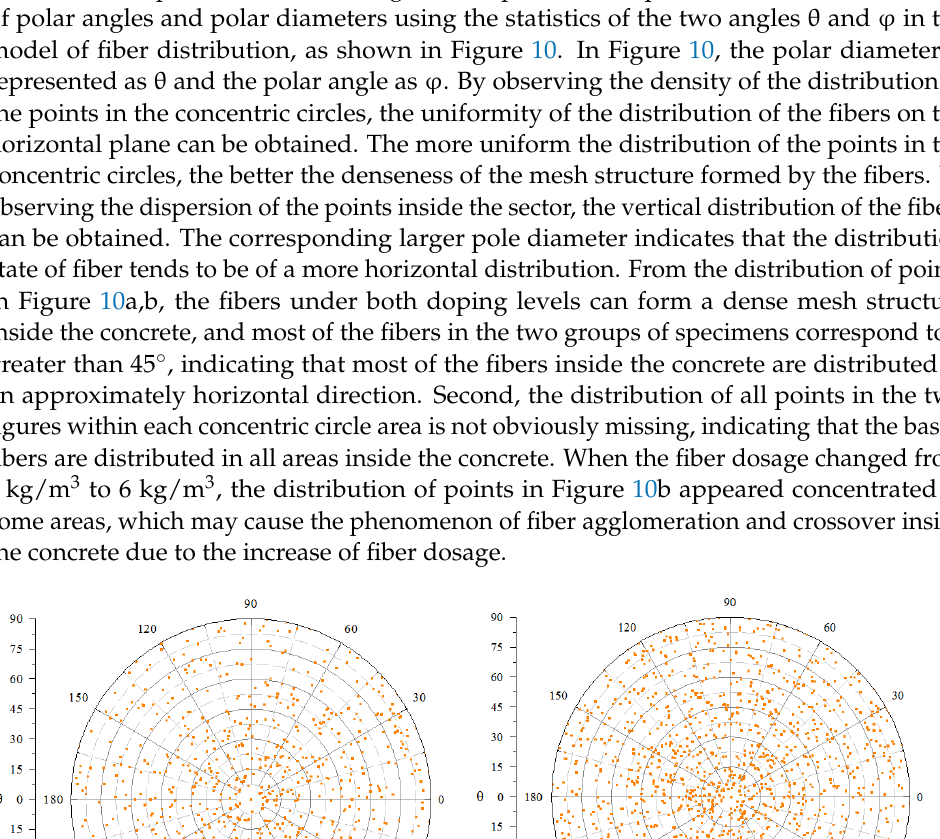
( c ) 6 kg/m 3 Figure 11. Experimental failure mode of compressive strength of test blocks with different fiber content. The uniaxial compression experiments reveal that the strength of plain concrete could reach 32.736 MPa, and the strength would increase with the addition of basalt fi- bers, and the increase is related to the fiber dosage amount. The highest strength of 43.168 MPa (31.9% increase) was achieved at 3 kg/m 3 and the lower strength of 35.648 MPa (8.9% increase) was achieved at 6 kg/m 3 .